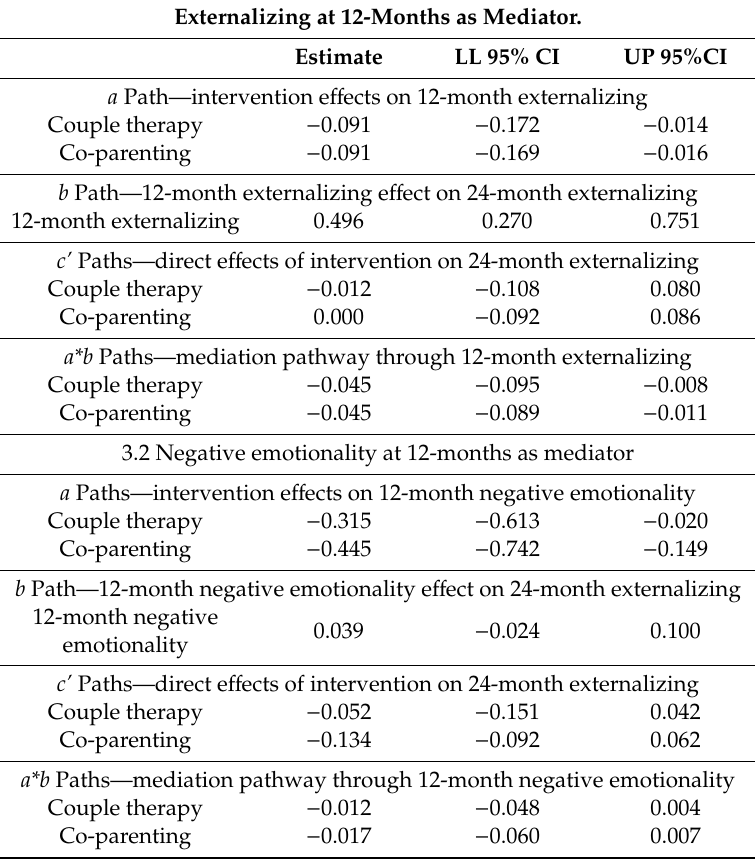
Table 3. Mediation pathways of intervention groups predicting 24-month externalizing symptoms. Externalizing at 12-Months as Mediator.